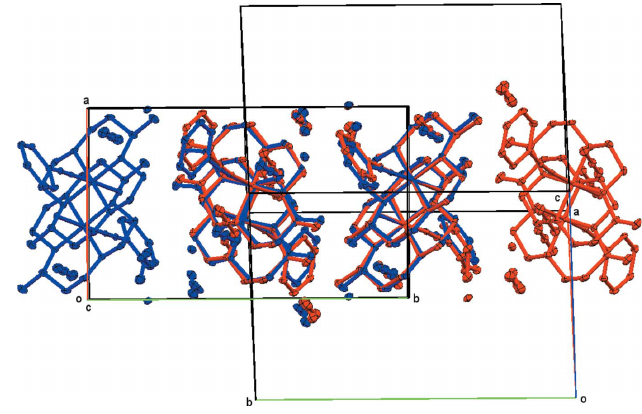
Figure 6 Overlays of a larger segment of the lattice of compound 1 . One of the overlaid cells was inverted for this purpose. The view is along the c axis of the original cell (blue atoms). The overlay is based on a least-squares fit of the four cobalt ions common to the overlaid